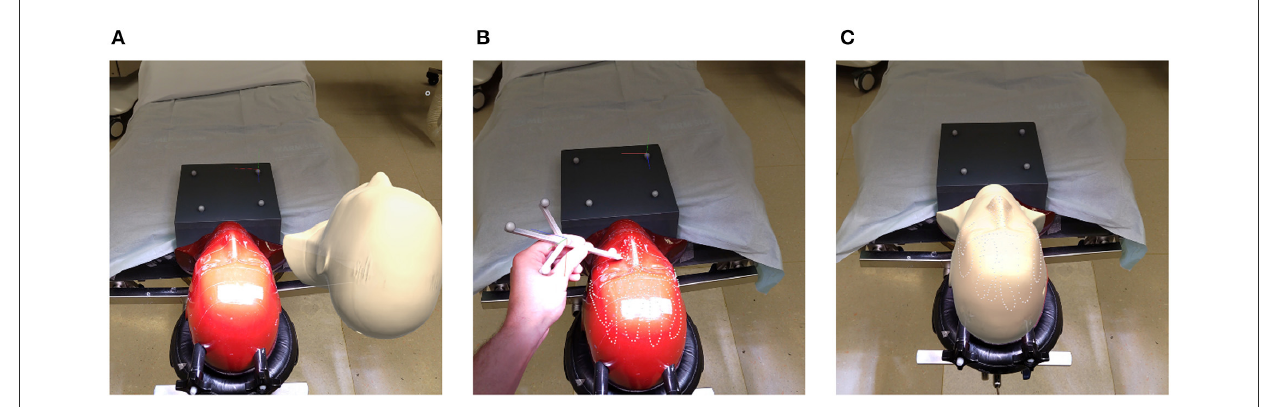
FIGURE4 Registration pipeline: (A) unregistered phantom; (B) refining initial alignment; (C) registered